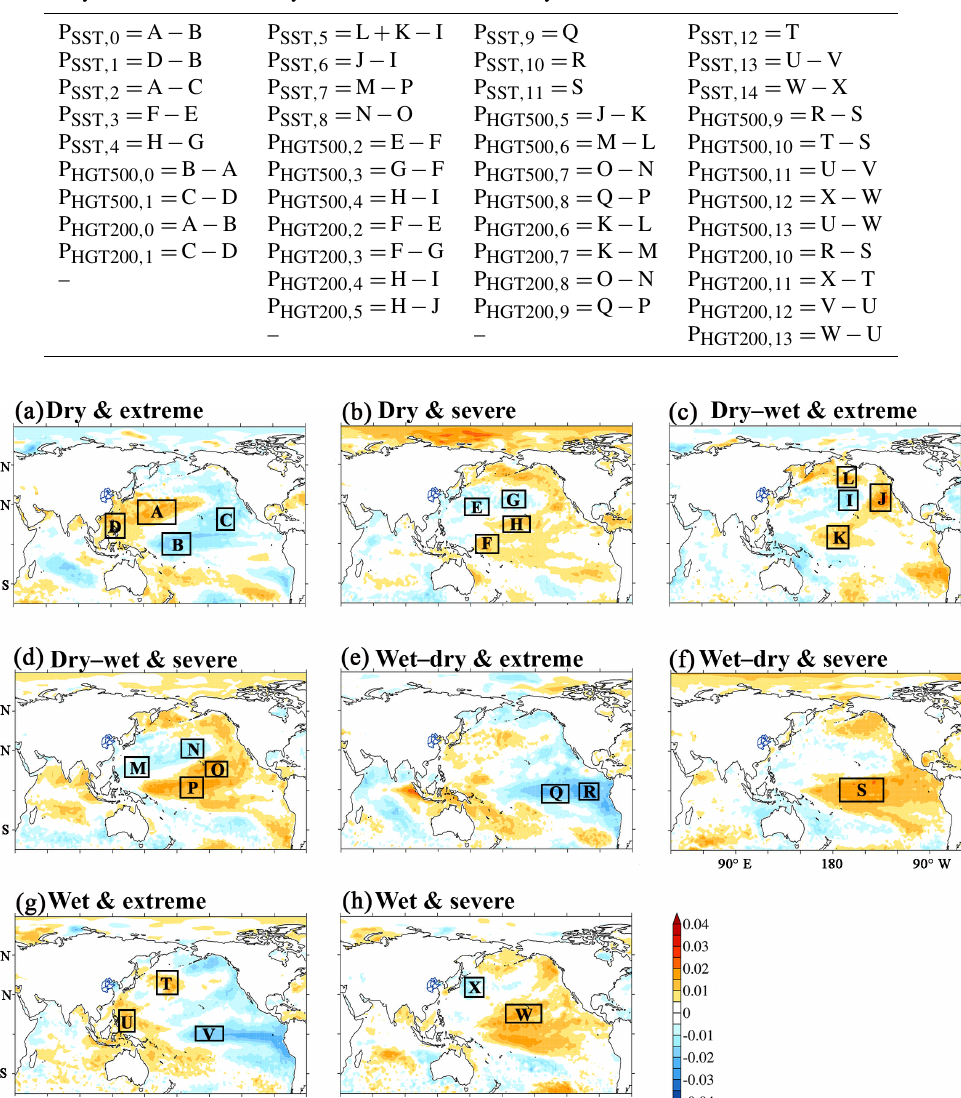
Figure 8. Same as Fig. 7, but for standardized anomalies (SAs) of SST fields associated with droughts in northern China.